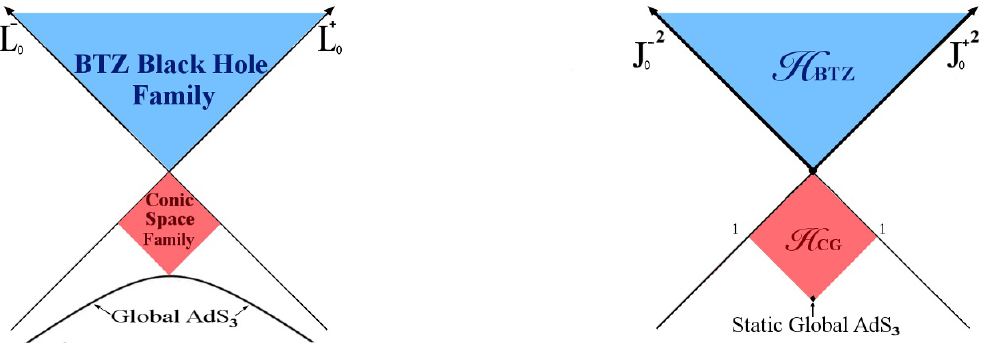
(left) and H J Vir